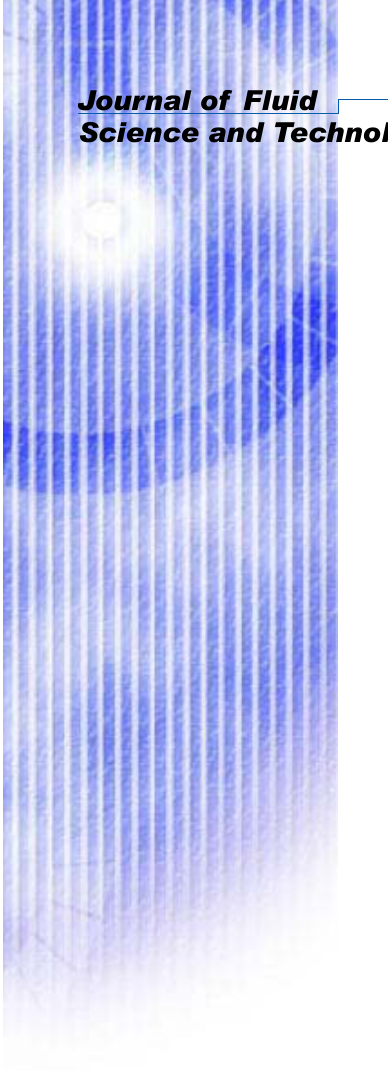
and y are two cut-off locations where their Ω * where y H L the subscript Δ appeared in Eq. (1) is also set equal to 5 % in consideration of 4.4 % uncertainty of velocity in the PIV measurements). The curves of y 4 for reference. Achievement of the self-preserving state can be effectively justified by monitoring the evolution of the inclined angle of the joint probability density function (PDF) at η = 0 as stated in our previous work (4) . Here η is a dimensionless transverse coordinate defined by